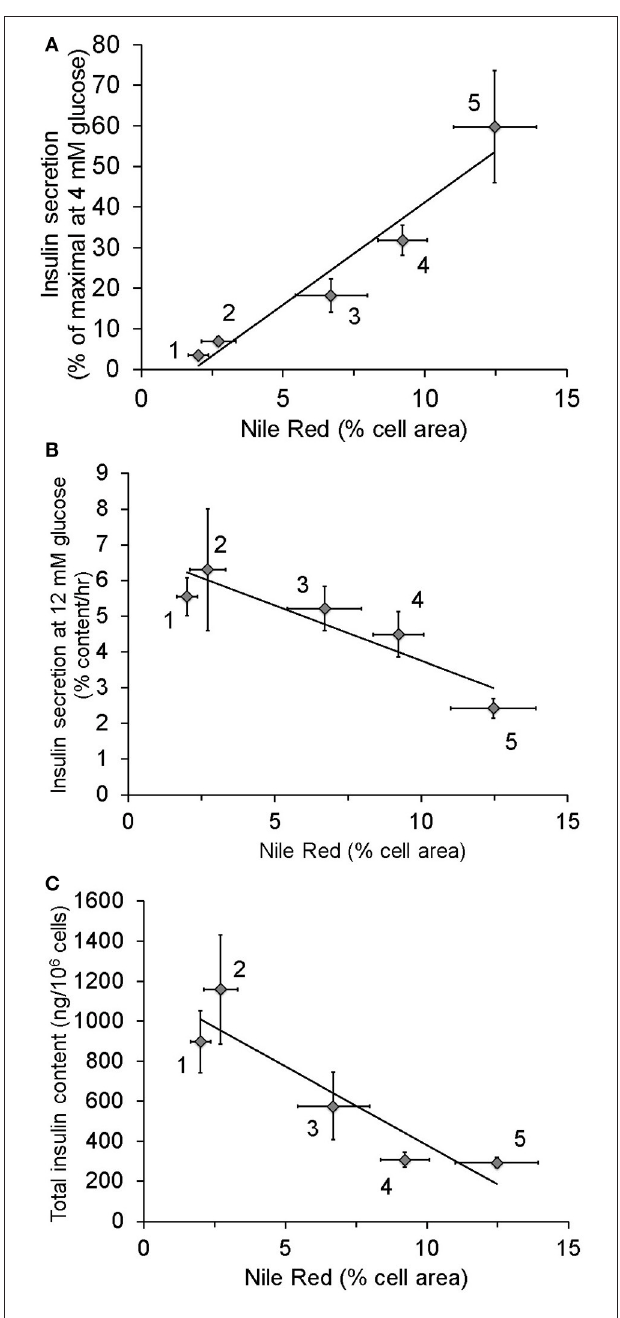
FIGURE 2 | Relationship between lipid stores, insulin secretion, and insulin content in INS1 (832/13) cells cultured in the presence of different nutrients: 1, 4mM glucose for more than 2 weeks (chronic) ( n = 12); 2, 4mM glucose for 48h ( n = 8); 3, 4mM glucose chronic + 0.15mM oleate for 24h ( n = 6); 4, 11mM glucose ( n = 13); 5, 11mM glucose + 0.15mM oleate for 48h ( n = 4). As standard culture media glucose concentration for INS1 cells is 11mM, cells identified as being cultured in 4mM glucose were switched from 11 to 4 for the stated period of time. Lipid content was measured using Nile Red. (A) Relationship between Insulin secretion at 4mM glucose following washout of growth media and lipid stores. (B) Correlation of intracellular lipid stores and insulin secretion at 12mM glucose. (C) Relationship between lipid stores and total insulin content. Data in this figure were recalculated from previously published results